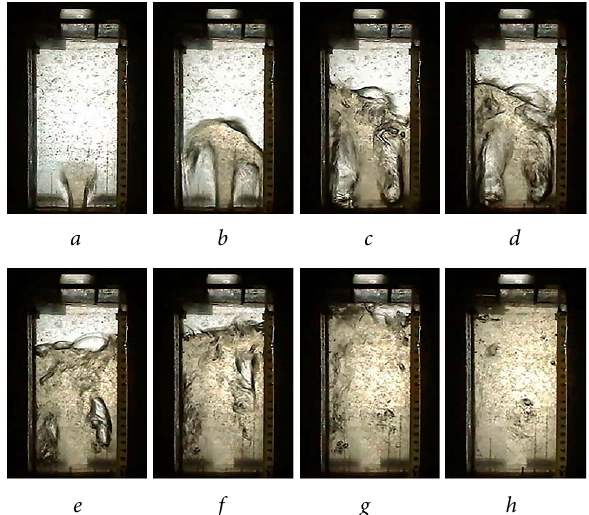
Fig. 4. Video frames of model cavity filling with a vacuum